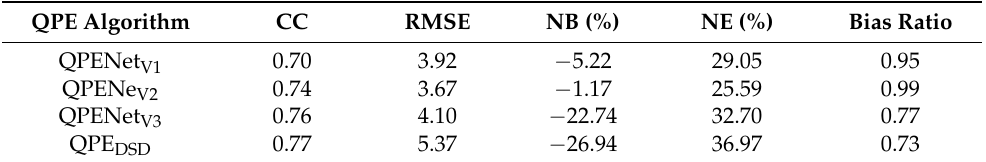
Table 7. The same as Table 5 except that the rainfall intensity is greater than or equal to 5 mm and less than 30 mm (5 ≤ R < 30 mm · h − 1 ).